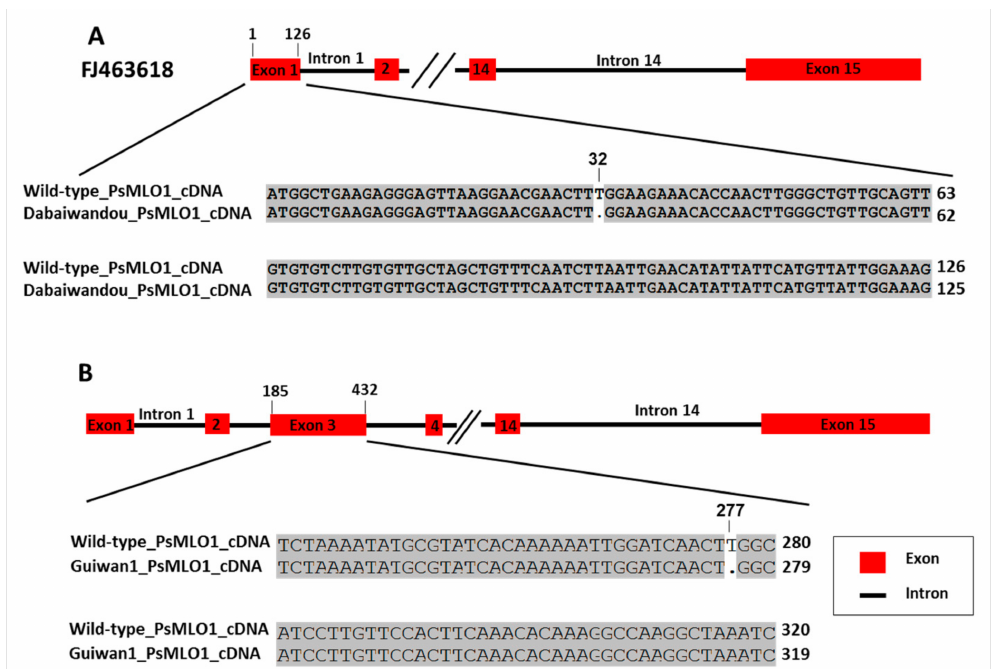
Figure 3. PsMLO1 cDNA sequence comparisons of those from the powdery mildew-resistant pea lan- drace Dabaiwandou and Guiwan 1 with the wild-type pea cultivar Sprinter (GenBank accession num- ber: FJ463618.1). ( A ) There is a single base deletion (T) in the PsMLO1 cDNA of Dabaiwandou at posi- tions 32 of exon 1. ( B ) There is a single base deletion (T) in the PsMLO1 cDNA sequence of Guiwan 1 at position277 in exon 3. The figure shows the difference of nucleotide sequence from Dabaiwandou, Guiwan 1, and the wild-type pea cultivar Sprinter. The two mutation sites are indicated in the respective cDNA